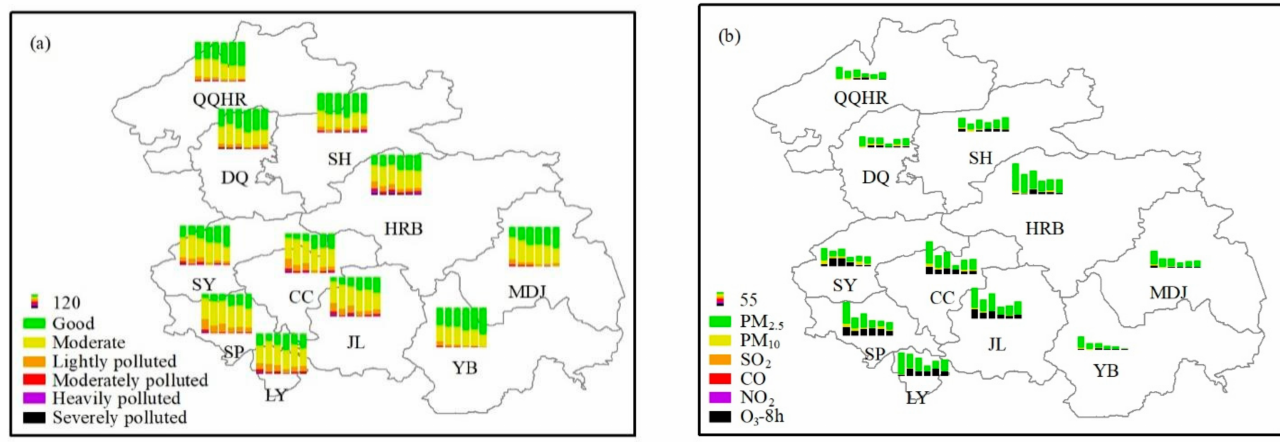
Figure 2. The six different polluted days and the major pollutants in different cities of HC. ( a ) The inter-annual change of six different polluted days in different cities of HC from 2015 to 2020. ( b ) The total non-attainment days (AQI > 100) and the major pollutants in the 11 cities of HC during 2015 to